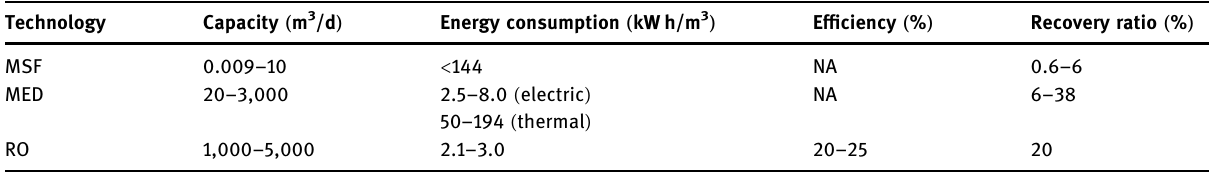
Table 9: Comparison of technology performance for desalination [ 127 ]